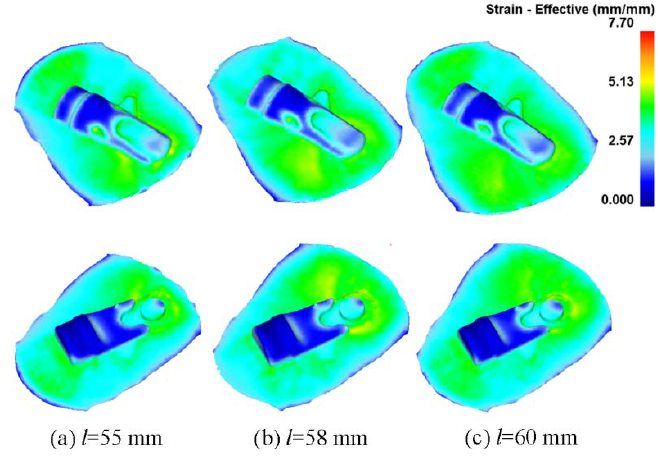
Figure 11. Distributions of effective strain of top and bottom part of component under different blank lengths: ( a ) l = 55 mm, ( b ) l = 58 mm, and ( c ) l = 60 mm.